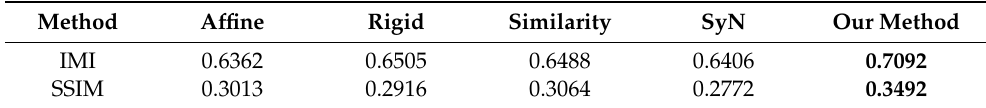
Table 3. The average IMI and SSIM metrics using different methods for all datasets. The best results are shown in